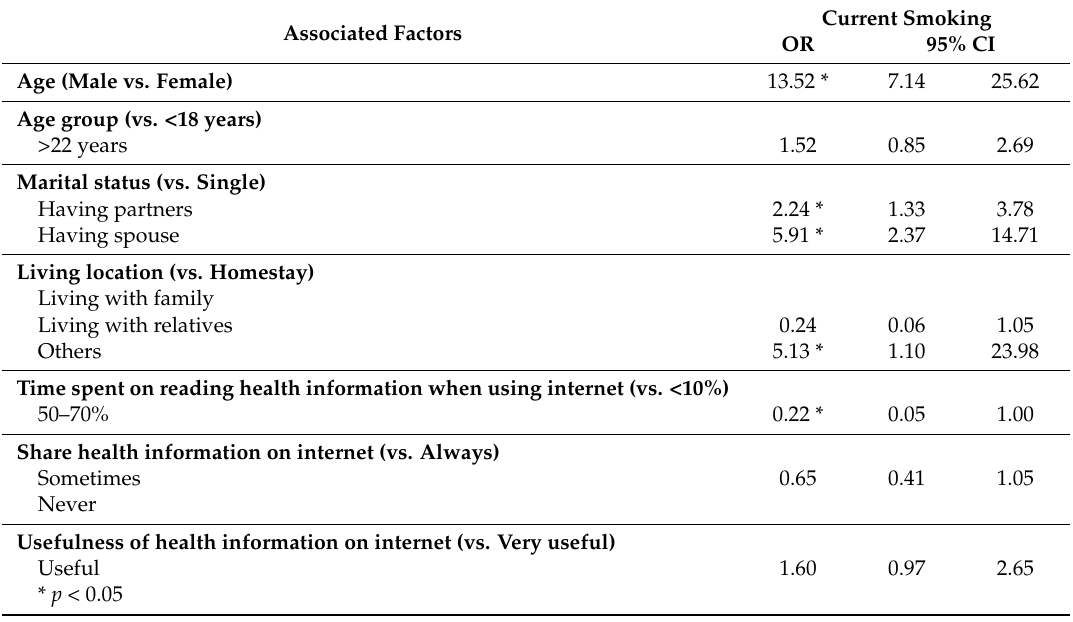
Table 4. Associated factors with current smoking ( n = 1082).